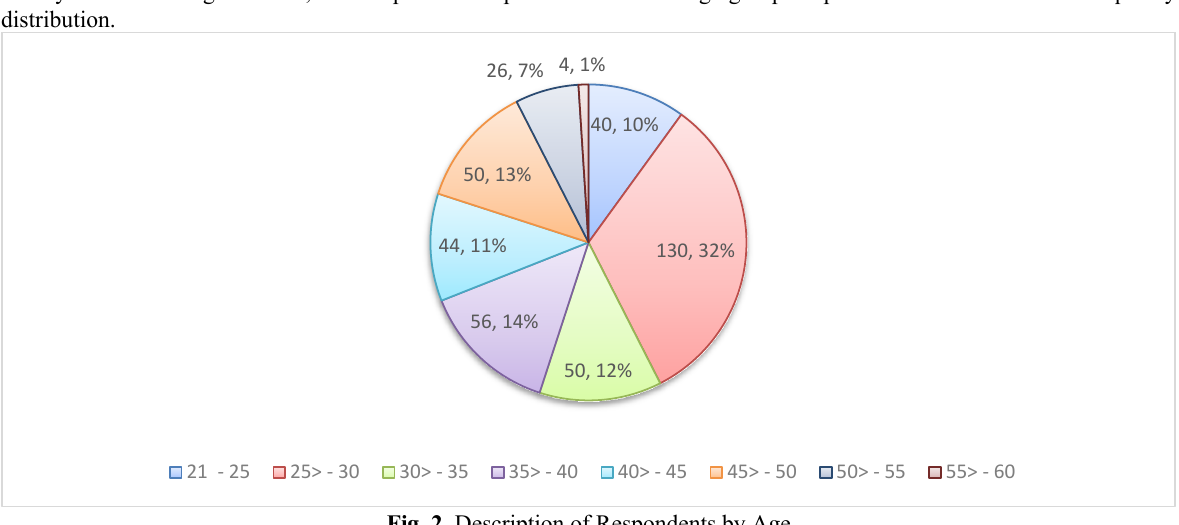
Source: Research Data Processing Results, 2020